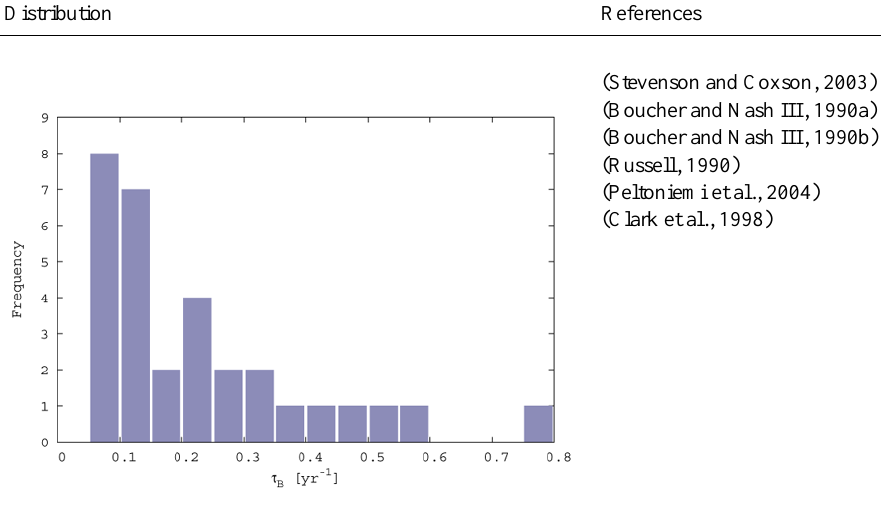
Fig. B15. Overview of the distribution of turnover rate τ B